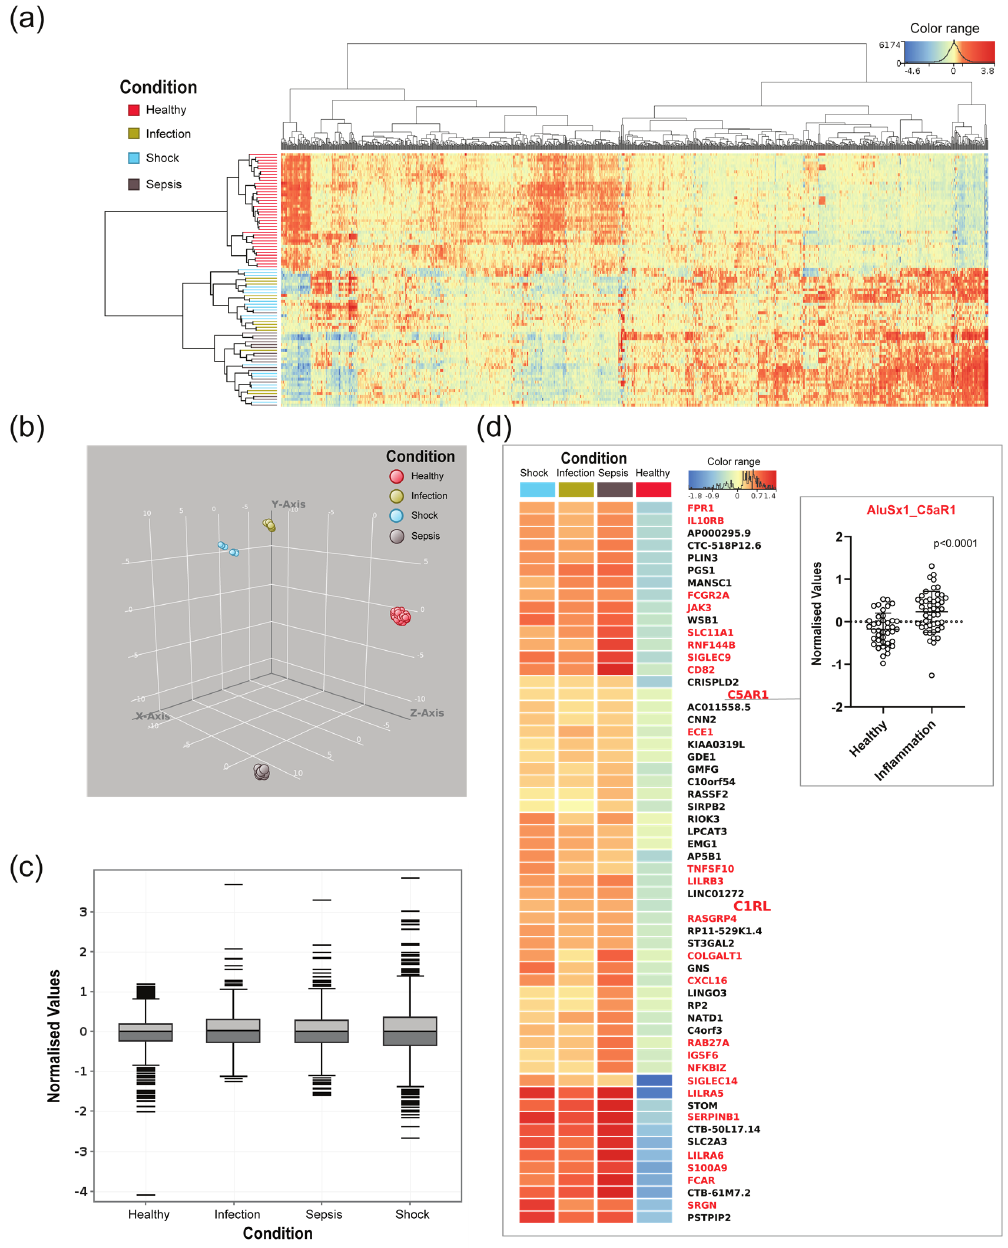
Figure 2. Expressed Alu elements transcribed from intragenic regions, from patients with infection, sepsis, septic shock, and healthy controls, displayed as hierarchical clustering and boxplot. ( a ) Heatmap produced in Strand NGS representing normalised values of intragenic Alu -containing transcripts, with a cut-off of 400 transcripts in at least one participant. This threshold produced 1173 Alu transcripts, represented in 716 genes. ( b ) UMAP supports clustering in Figure 1a, but in addition, shows that the dataset is separated between the conditions. ( c ) Boxplot showing normalised expression transcribed from intragenic regions and containing Alu elements. The boxes mark the medians and the upper and lower quartiles, and the whiskers extend to the most extreme values. ( d ) Heatmap of Alu -containing transcripts with the highest expression (>1000 raw reads in one or more samples) and highest fold change (threshold 1.3) between patients with inflammation and healthy controls. Alu transcripts from within the same genes are aggregated and produced transcripts from 58 genes that had at least one Alu insertion. Genes in red letters represent immune genes as defined by the Innatedb.com database (accessed on 1 December 2021). Box connected to AluSx1 C5aR1 shows p -value of p ≤ 0.001.